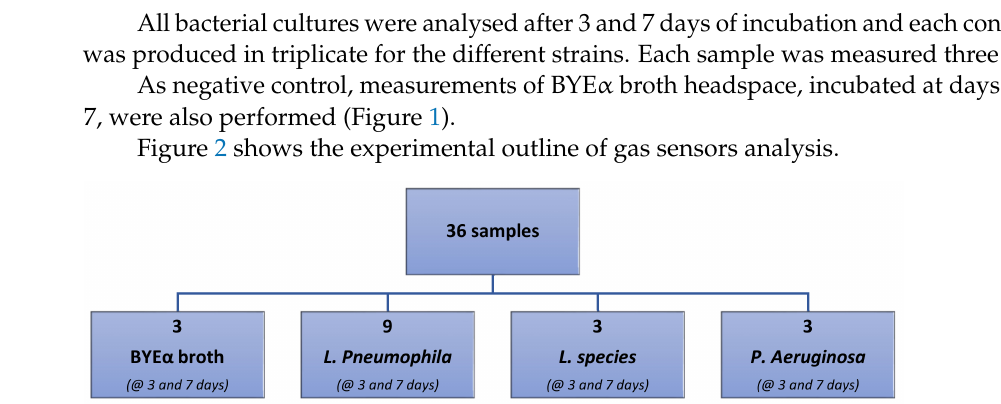
Figure 2. Experimental outline of gas sensor array analysis.